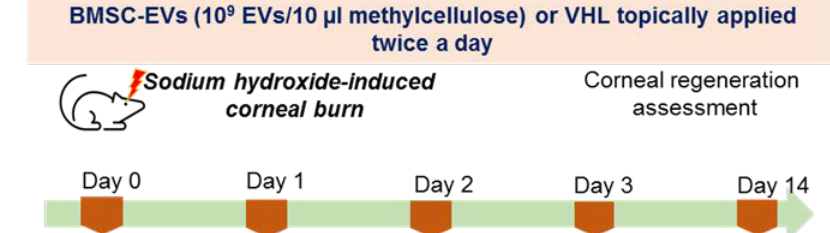
Figure 2. MSC-EV treatment of murine corneas upon alkali burn. ( A ) Confocal microscopy images of corneal whole mounts, reconstructed using the mosaic function of Leica Sp5 confocal microscope, following treatment of the injured or uninjured control corneas with PKH26-labelled (Red) MSC-EVs at 10 × magnification. Inserts are shown at 40 × magnification (scale bar: 50 nm). F-actin and nuclei were stained with phalloidin-FITC (green) and DAPI (blue), respectively. Representative images are shown (n = 2, biological replicates). ( B ) Alkali burn induction and EV treatment schedule in mice. Corneal regeneration was assessed during a 14-day time